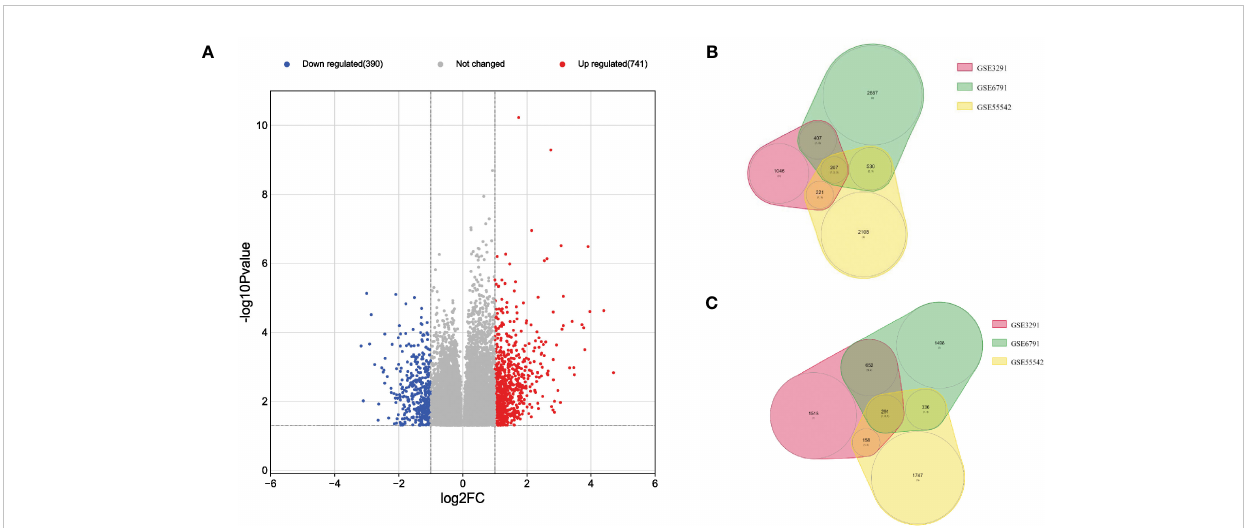
FIGURE 1 Visualization of the DEGs across the three transcriptomic datasets of HNSCC patients. (A) Volcano plot with the blue points representing 207 down- regulated genes and the red points representing 291 up-regulated genes in HPV + compared to HPV - HNSCC patients, Venn Diagrams of; (B) down- regulated and (C) up-regulated genes in HPV + compared to HPV - HNSCC